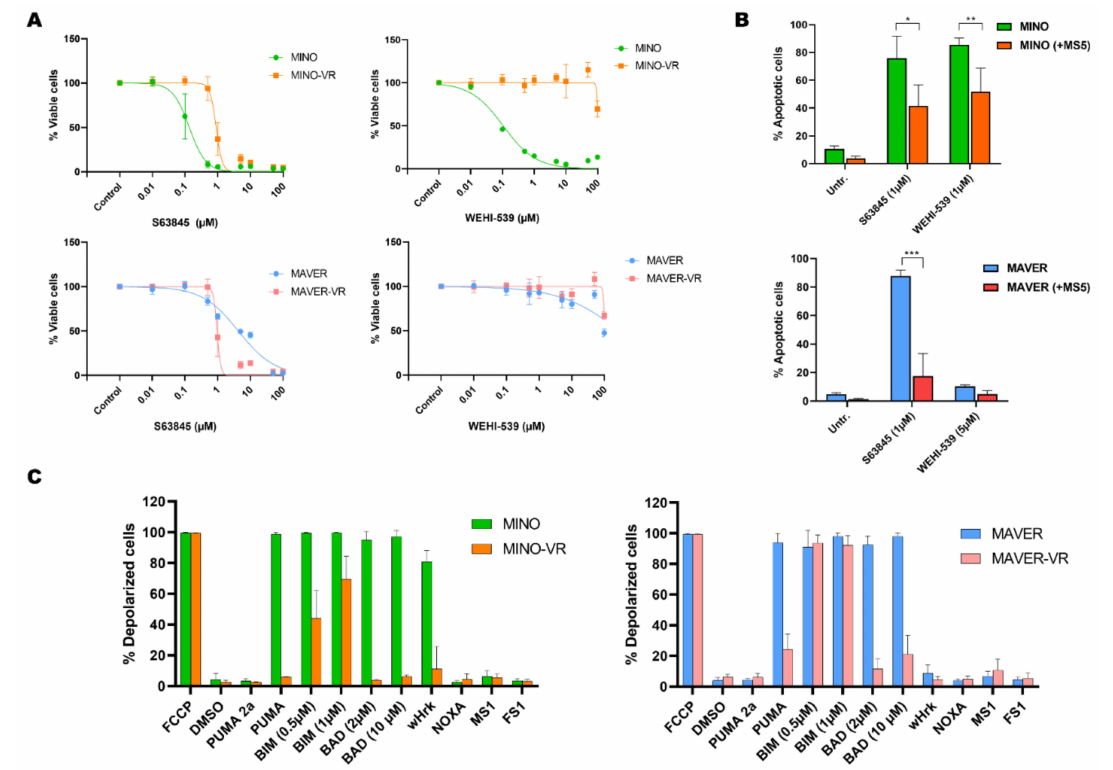
Figure 2. ( A ) Dose-response curves for the MCL-1 inhibitor S63845 and the BCL-XL inhibitor WEHI- 539 in MINO/MINO-VR (upper panels), and MAVER/MAVER-VR (lower panels). ( B ) Bar charts of the apoptotic response to S63845 in co-cultures of MINO (upper) and MAVER-1 (lower) with MS-5. Data are presented as mean + SD ( n = 3). ( C ) Bar charts with a summary of BH3 profiling data for MINO/MINO-VR (left) and MAVER/MAVER-VR (right) in MS-5 co-cultures. Data are presented as mean + SD ( n = 3). Abbreviations: MINO-VR: venetoclax-resistant MINO; MAVER-VR: venetoclax-resistant MAVER-1. * p < 0.05, ** p < 0.01 and *** p <